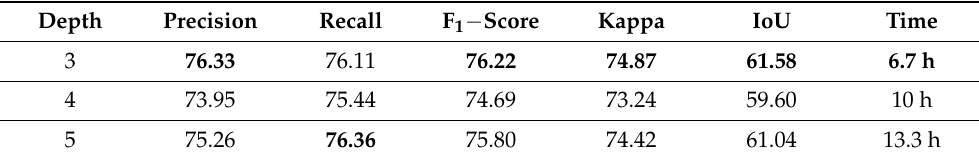
Table 4. Performance of U − Net++256 with different depths. The bold represents the maximum value of each indicator under three different network